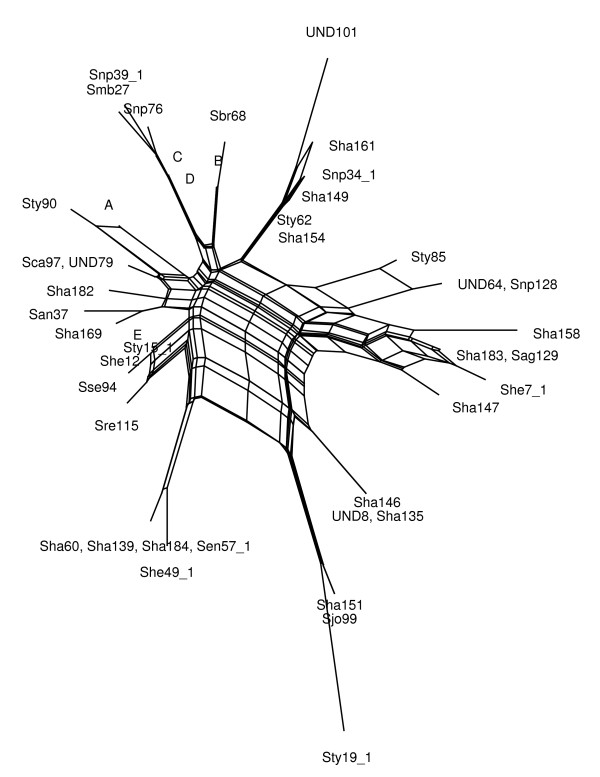
The N-Net network for the Salmonella data set. Group A includes the isolates Sty54, Sty54*, Sty2, She9, Sty87, Snp40*, Sty13, Snp41*, Sen5, Sha160, Sha141, Sty20*, Sha58, Sse18, Sha71, Sty31. Group B includes the isolates Sty61, Sha148, Smb-17, Sag75, Sha124. Group C includes the isolates UND3, Sha150, Sha173, Sen23*, Sha153, Sha140, San96, Sen30*, Sen24*, Sha138, Sha176, Sha130, Sha164, Sha157, Sen29*, Sca93, Sha122, Sht20, Sha186. Group D includes the isolates She3, Sha50, Sse95, Sha56, Sen24, Sen34, Sha177, Sty13*, Swo44, Sty86, Ste41, Sha77, UND80. Group E includes the isolates Ssc40, Sse28, Sty89, Sty15*, Ske69, UND110, Sha49, Sen4, Sha48, Sha165, Sty92, Snp33*, Sty52, UND109, Sha131, Sha102, Sty6, Sha175.